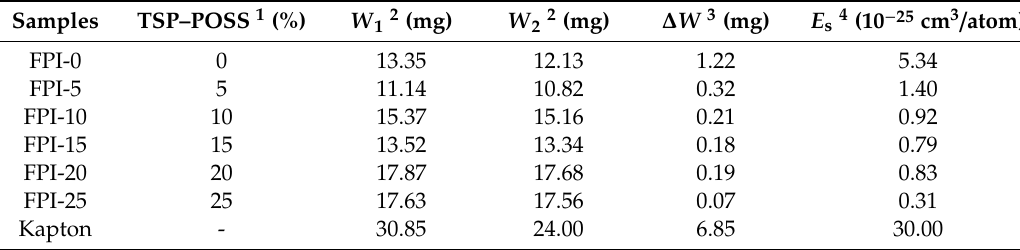
Figure 14. AO erosion yields of the PI films (Insert: FE-SEM images of FPI-0-AO and FPI-25-AO after exposure to 4.0 × 10 20 atom / cm 2 AO attack, respectively). Table 3. AO e ff ects and erosion yields for PI